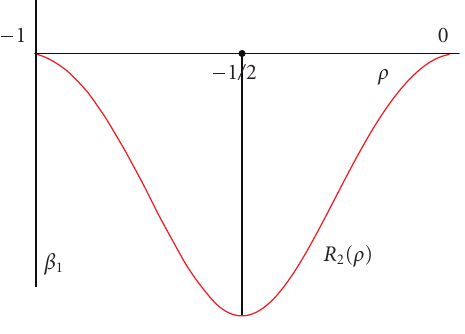
Figure A.2. Function R 1 ( ρ ) for m 1 = m 2